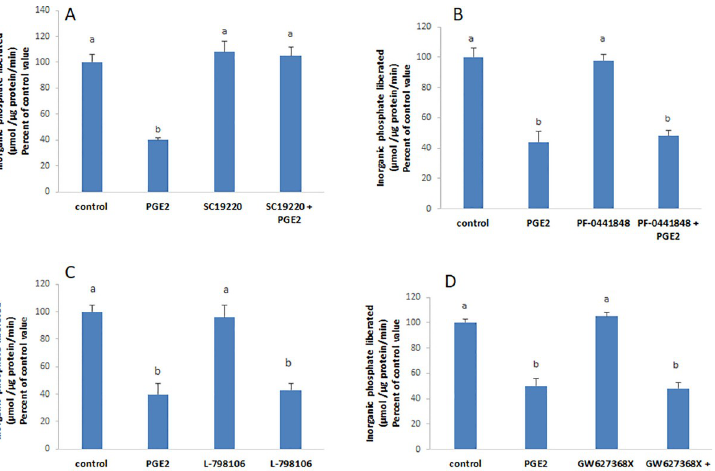
Fig 2. PGE2 binds to EP1 receptors. PGE2 (1 nM, 20 min) could not inhibit the Na + /K + ATPase in presence of an antagonist to (A) EP1 receptors (SC 19220; 100 μ M), while its effect appeared unaltered in presence of blocker of ( B) EP2 (PF-7981106; 1 μ M), ( C) EP3 (L-798106; 1 μ M) and (D) EP4 receptors (GW 627368X; 10 μ M). Values are means ± SEM of at least 3 observations. Bars not sharing a common letter are considered significantly different from each other at P <